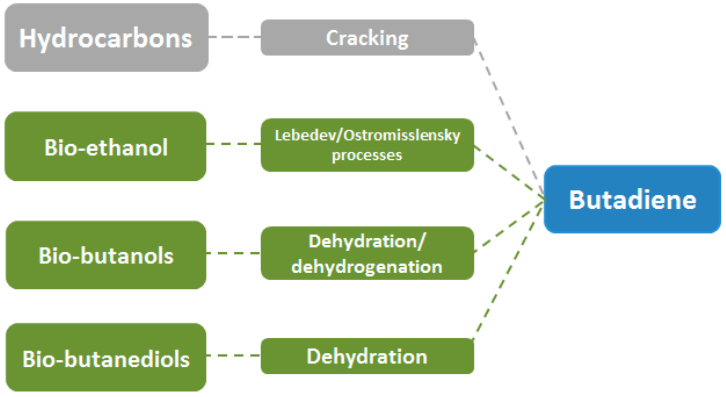
Figure (cid:561) 9, (cid:561) the (cid:561) various (cid:561) production (cid:561) processes (cid:561) for (cid:561) C 4 H 6 (cid:561) are (cid:561) summarized. (cid:561)